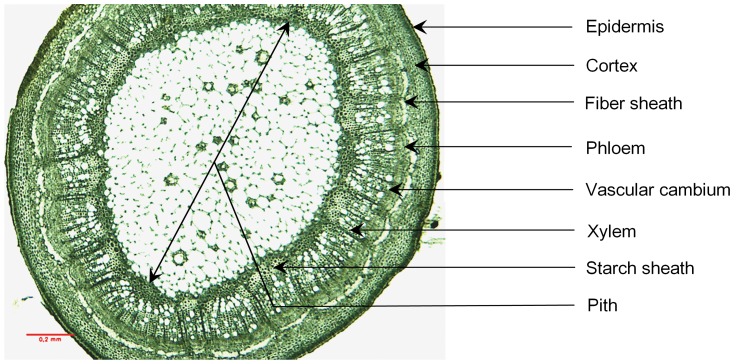
A terminal shoot cross-section.A photograph of Acer sinense var. concolor showing a typical anatomical structure of a terminal shoot.